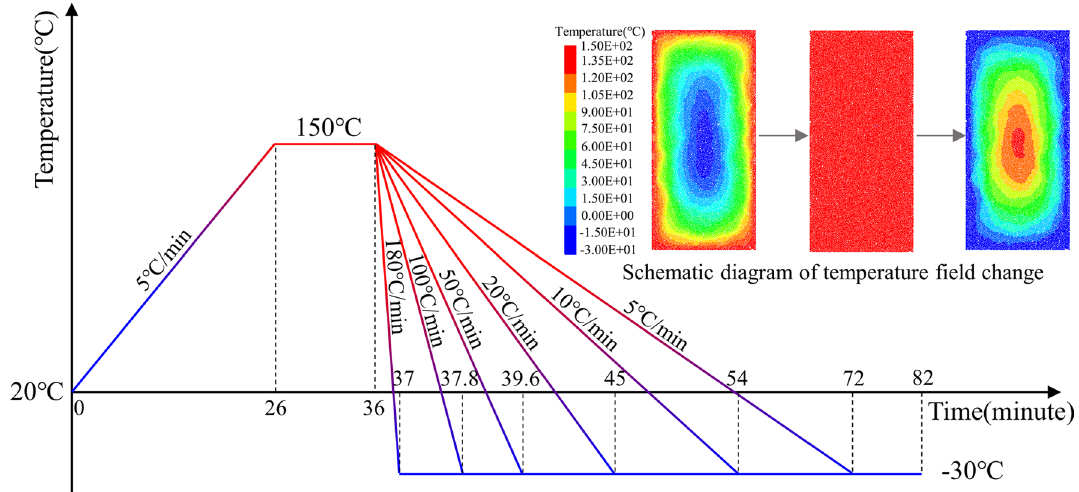
Fig. 5 Temperature boundary variation curve of numerical